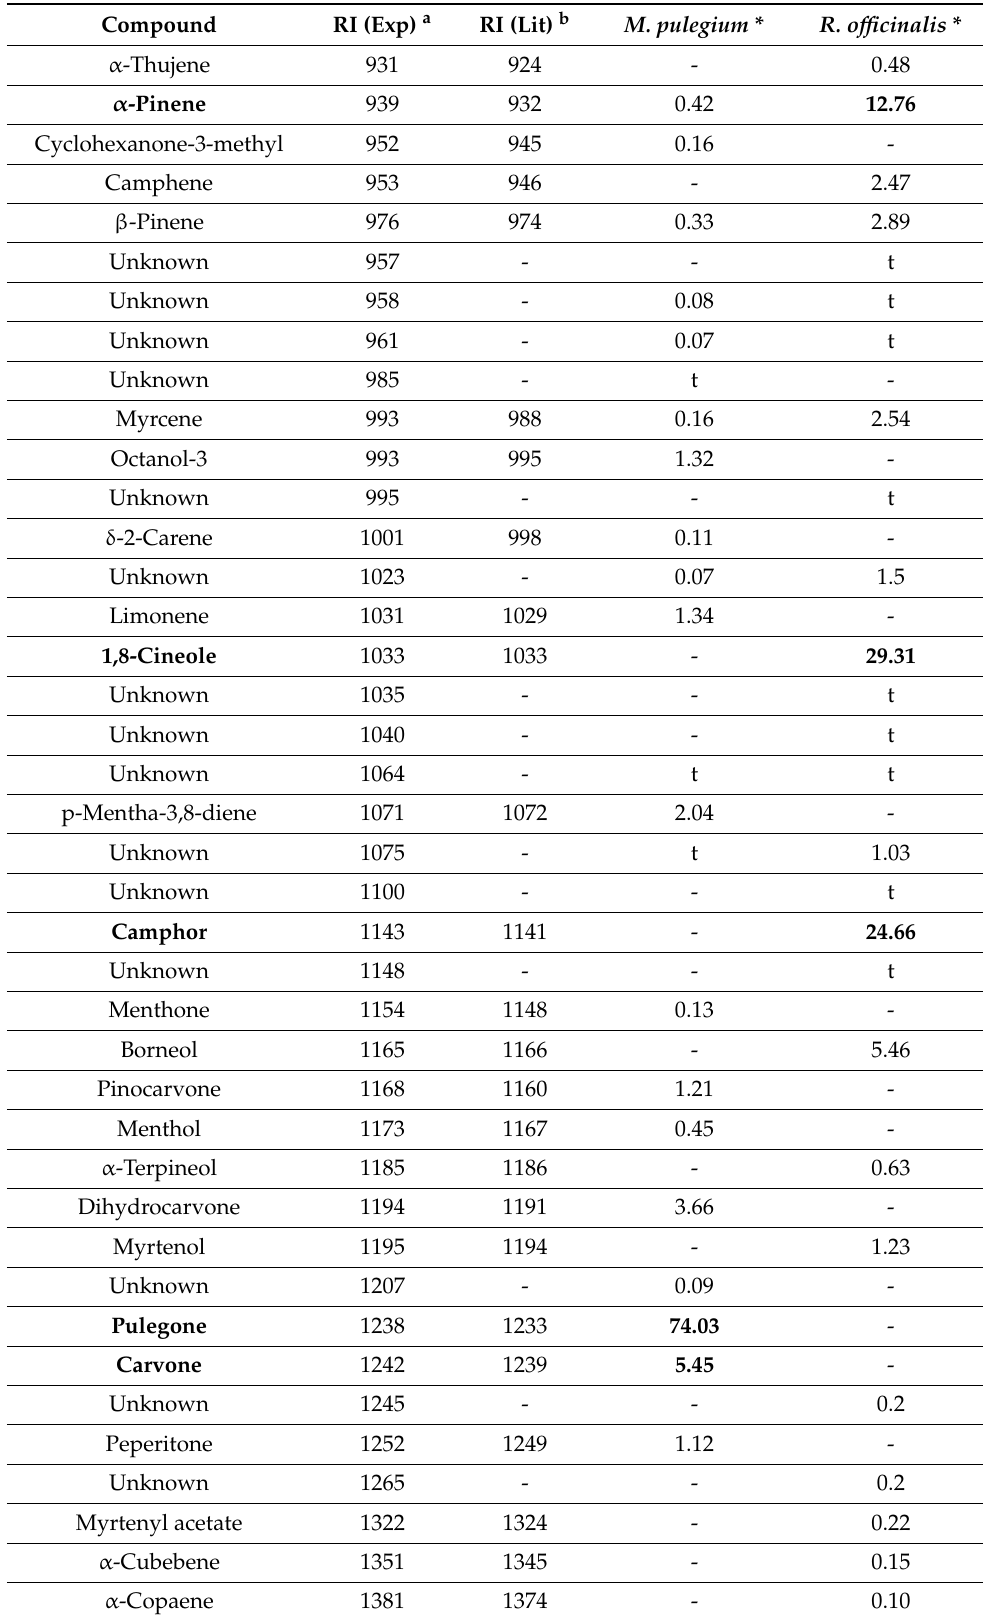
Table 1. The chemical compounds identified in M. pulegium and R. officinalis EOs.